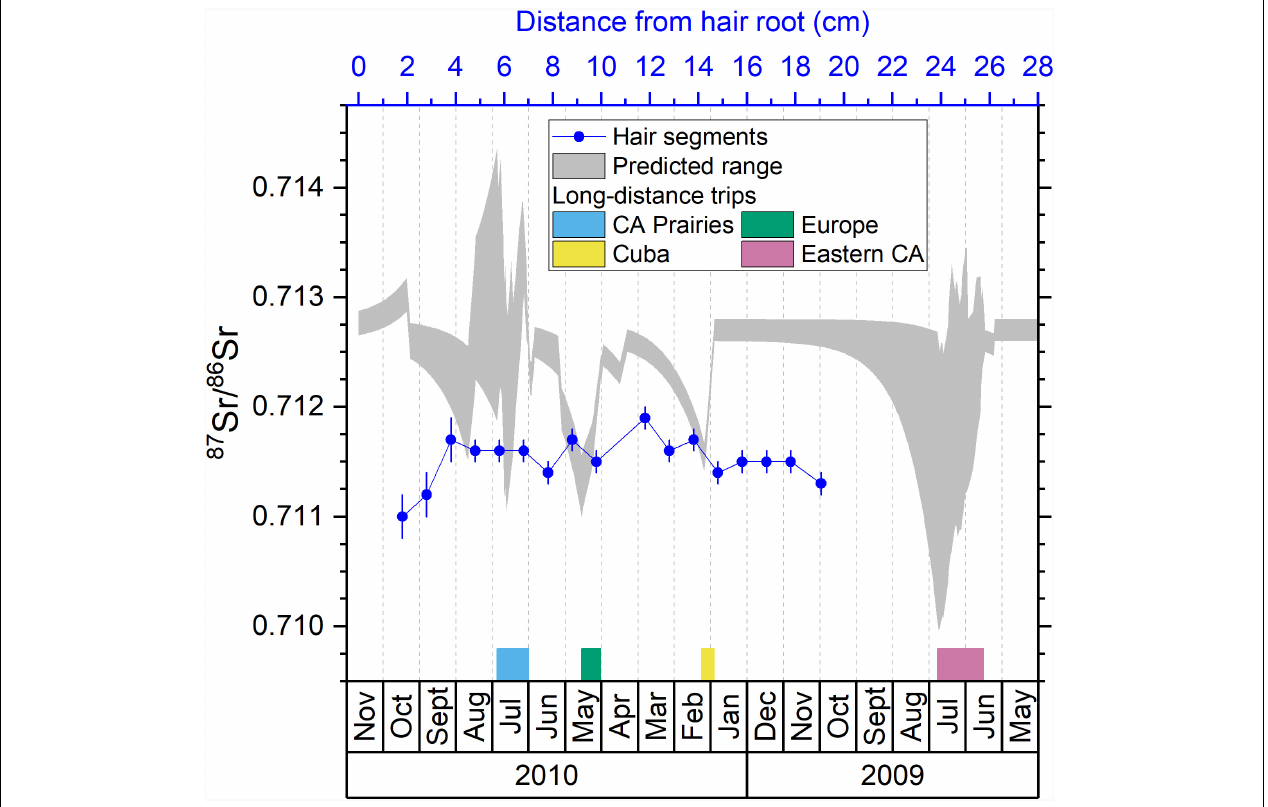
FIGURE 5 | Comparison between the predicted isotopic profile and the measured isotopic ratios in hair segments for strontium. Blue dots are the measured 87 Sr/ 86 Sr ratios in hair segments versus their distances from the hair root (top axis) . The shaded area is the predicted range of 87 Sr/ 86 Sr ratios in hair versus the date (bottom axis) . The periods of the four major trips are marked with colored bars next to the bottom axis.